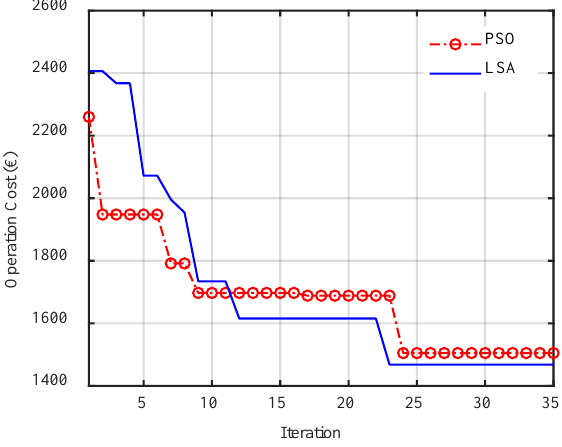
Figure 10. The convergence process of PSO and LSA for the first scenario.